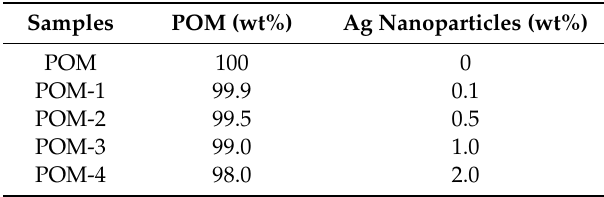
Table 1. The compositions of POM / Ag